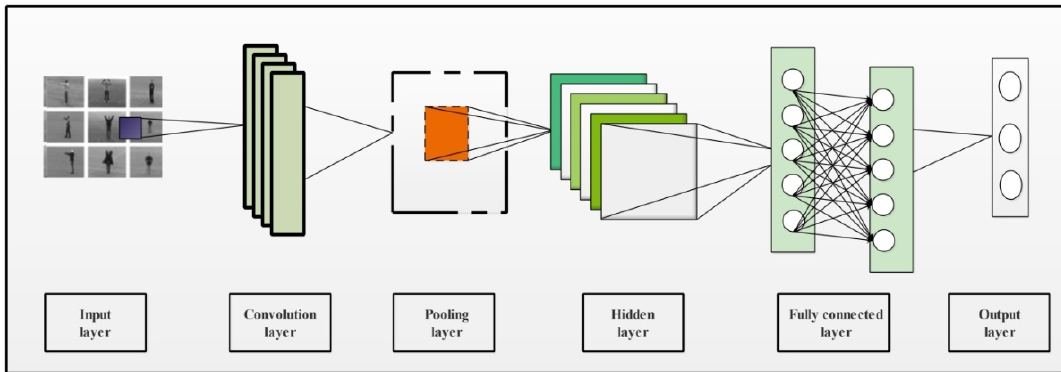
Figure 2. A simple architecture of CNN containing multiple layers for image classification.